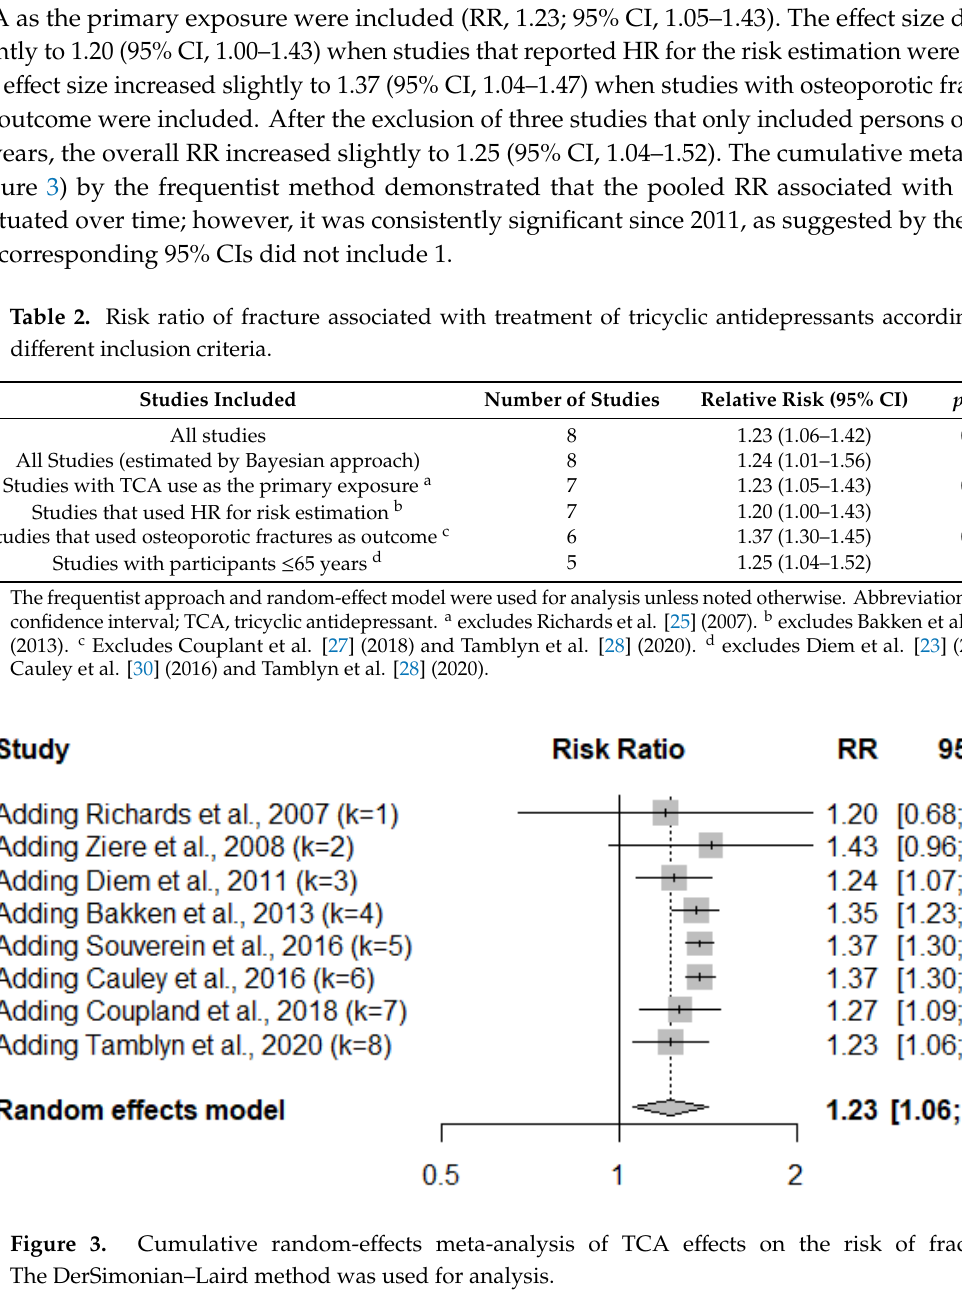
Table 3. Fracture risk associated with the use of tricyclic antidepressants in the subgroups analysis defined by the following characteristics: anatomical site of fracture, confounder adjustment, years of publication, study location and quality score. Studies Included